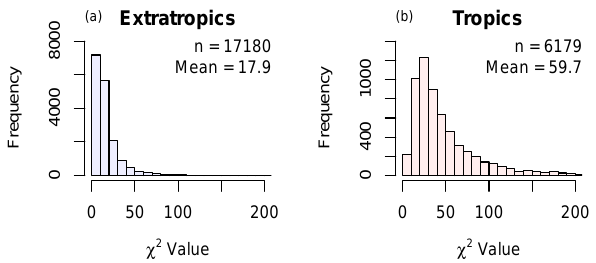
χ 2 Value Figure 13. Distributions of χ 2 values in the tropics and extratrop- ics. The distribution of the χ 2 value in the tropics (b) implies that the forward model is not correctly simulating the reflectivity in the tropics, while the distribution of the χ 2 value in the extratropics (a) indicates successful